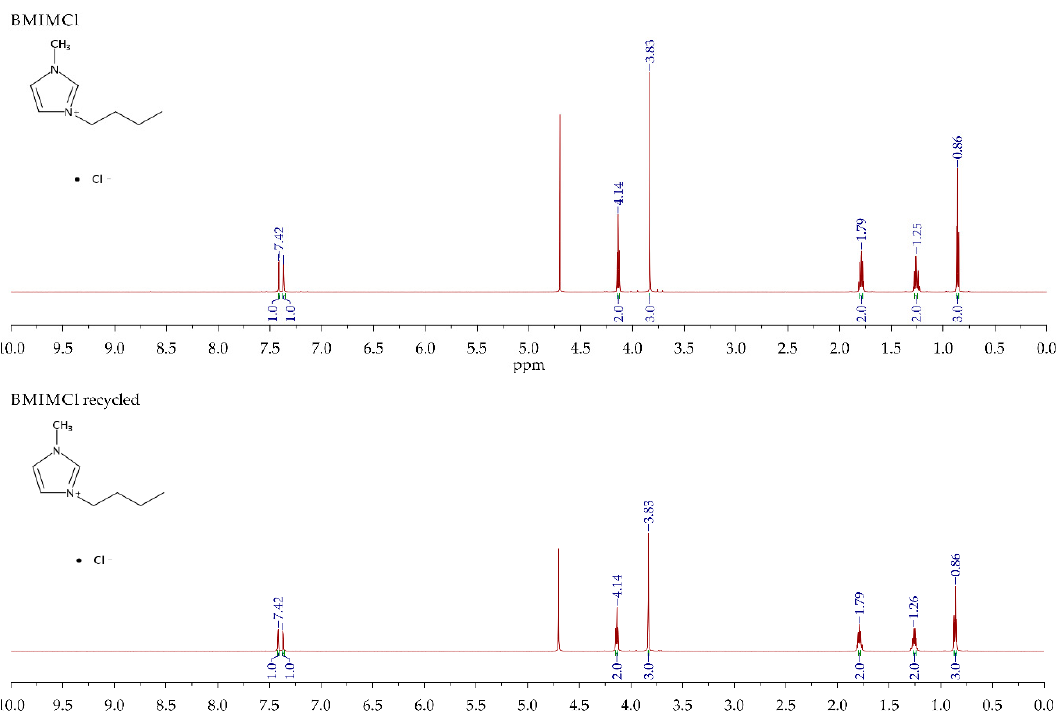
Figure 6. 1 HNMR spectra of pure IL ( top ) and recycled IL ( bottom ).